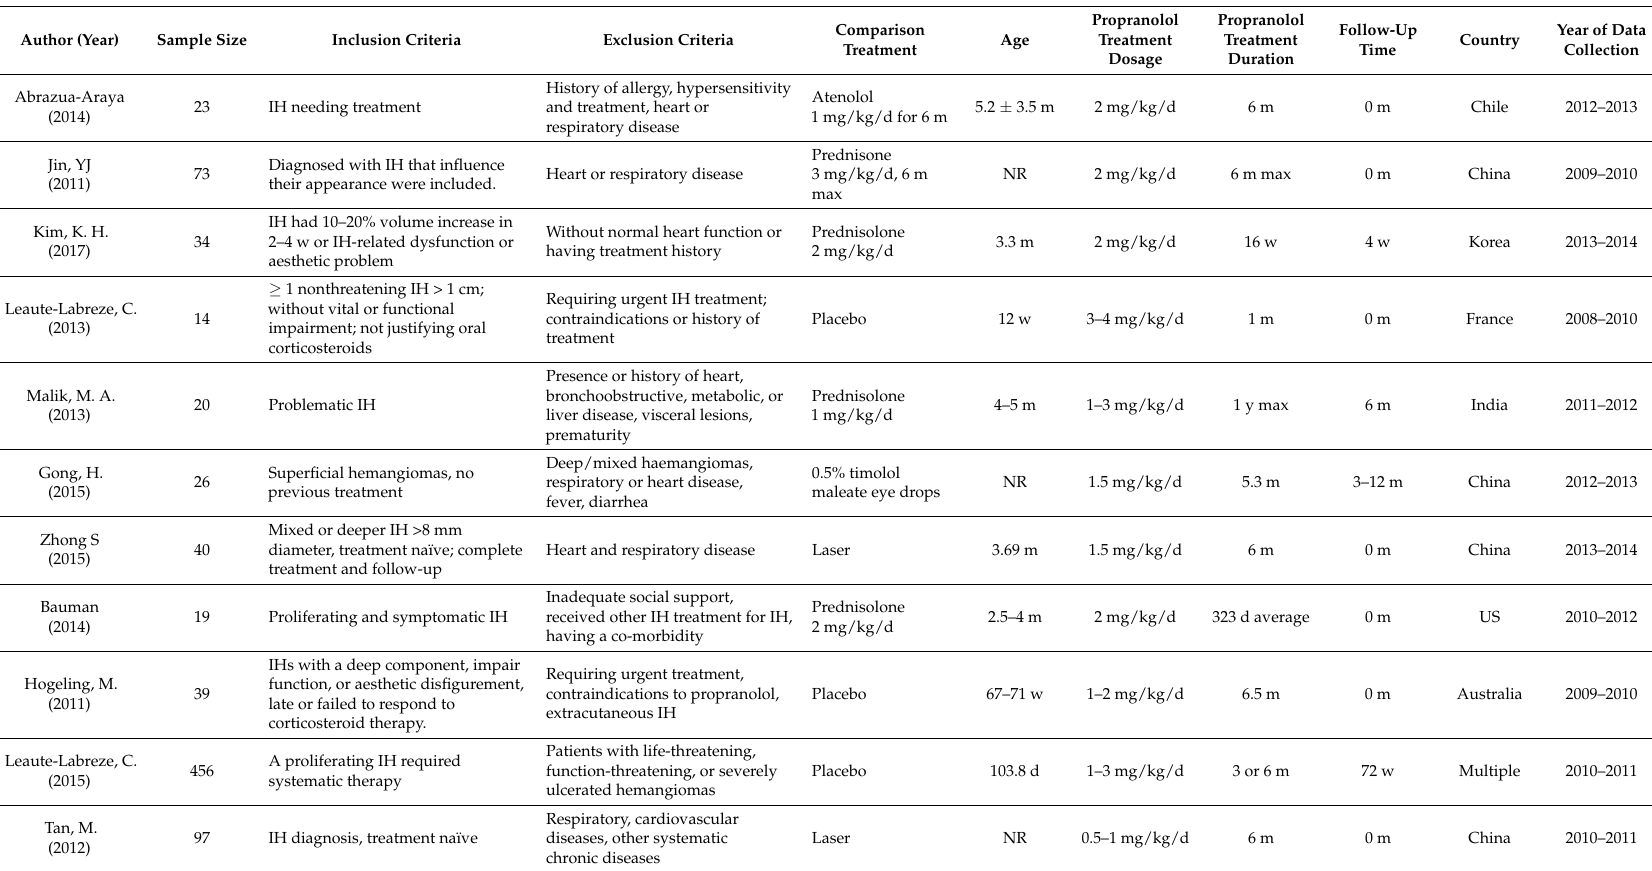
Table 1. Study characteristics of included